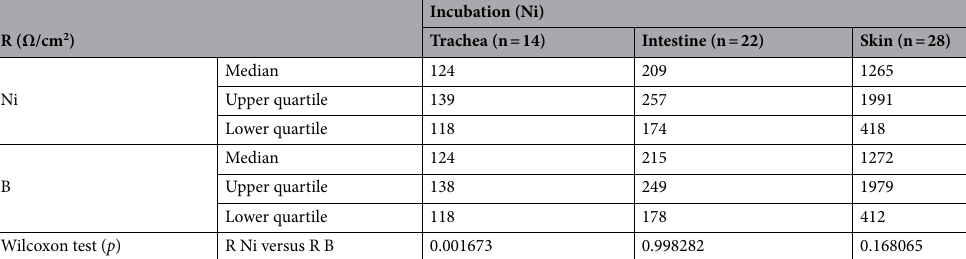
Table 2. Transepithelial resistance (R) of the trachea, intestine and skin measured in stationary conditions at the beginning of experiments and treated by the solution of nickel chloride (0.1 mM) and bumetanide (0.1 mM). The values of medians and lower and upper quartiles are given. Abbreviations: B—bumetanide (0.1 mM) solution, Ni—nickel chloride (0.1 mM) and bumetanide (0.1 mM) solution, R—resistance measured at the beginning of experiments (Ω/cm 2 ), p < 0.05;